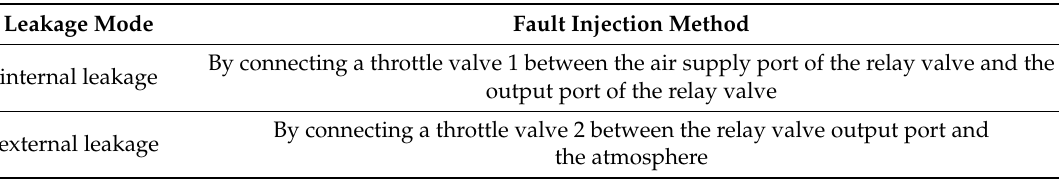
Figure 5. Relay valve leakage simulation test platform. Table 3 lists the relay valve fault injection methods for internal and external leakage. Table 3. Relay Valve Leakage Fault Injection Method.